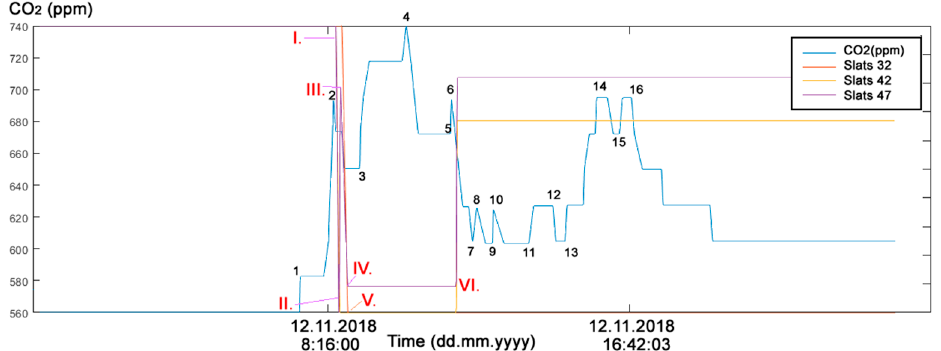
Figure 8. The reference (measured) CO 2 concentration course and Slats course (12 November 2018) in room R203 (Figure 2) in SHC for ADL monitoring. (1) arrival (12 November 2018 7:33:00), (2)